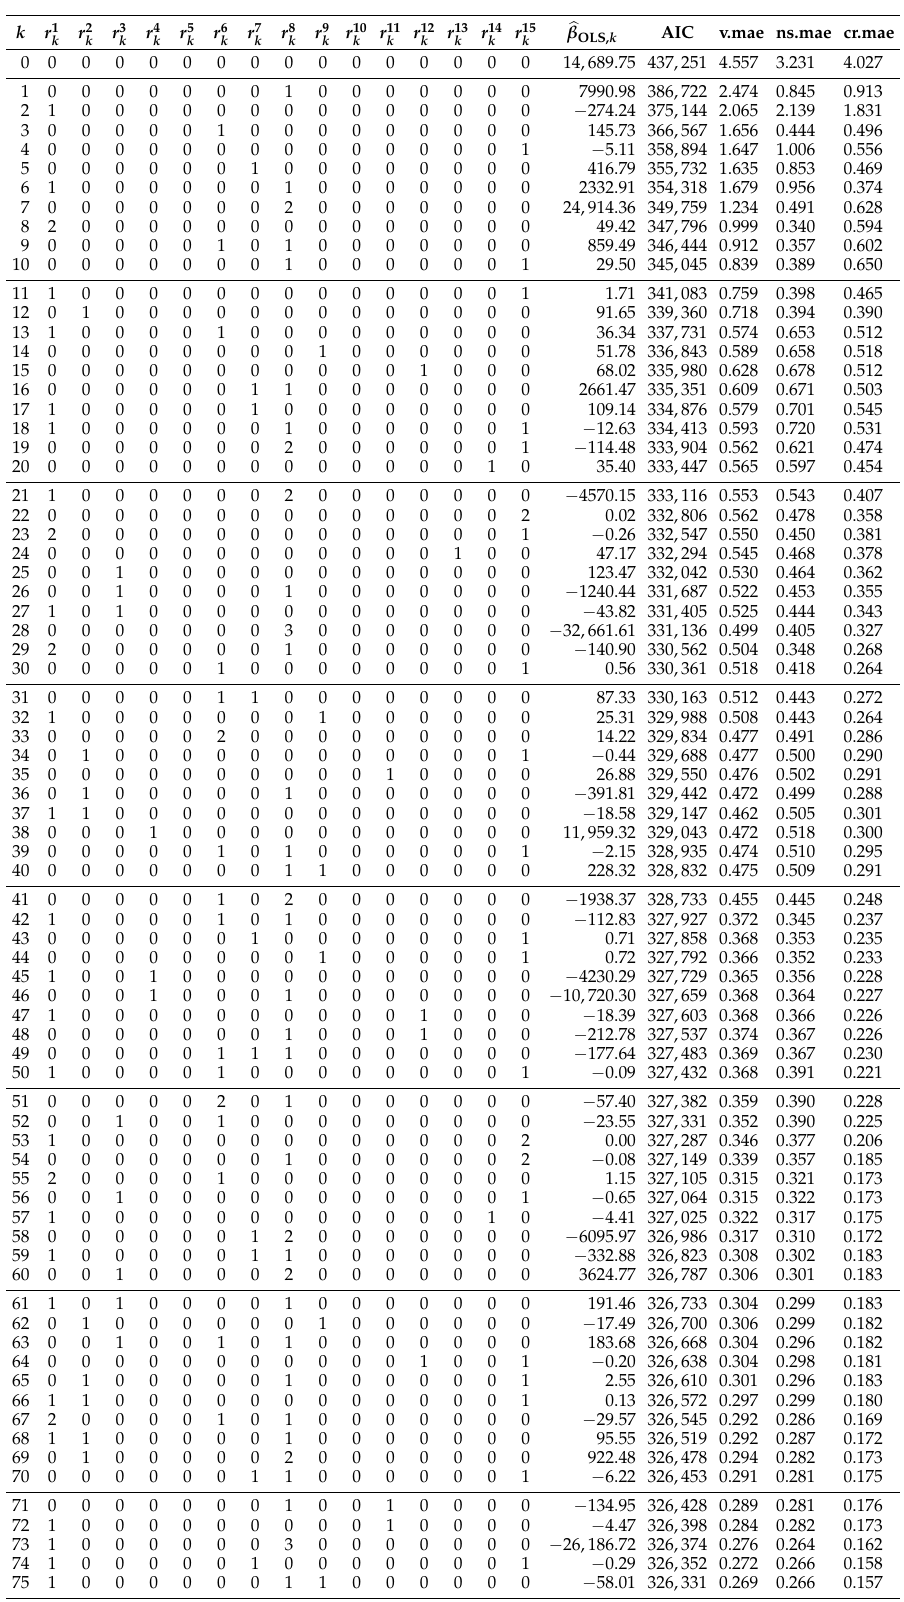
Table A3. OLS proxy function of BEL derived under 300–886 in the adaptive algorithm with the final coefficients. Furthermore, AIC scores and out-of-sample MAEs in % after each